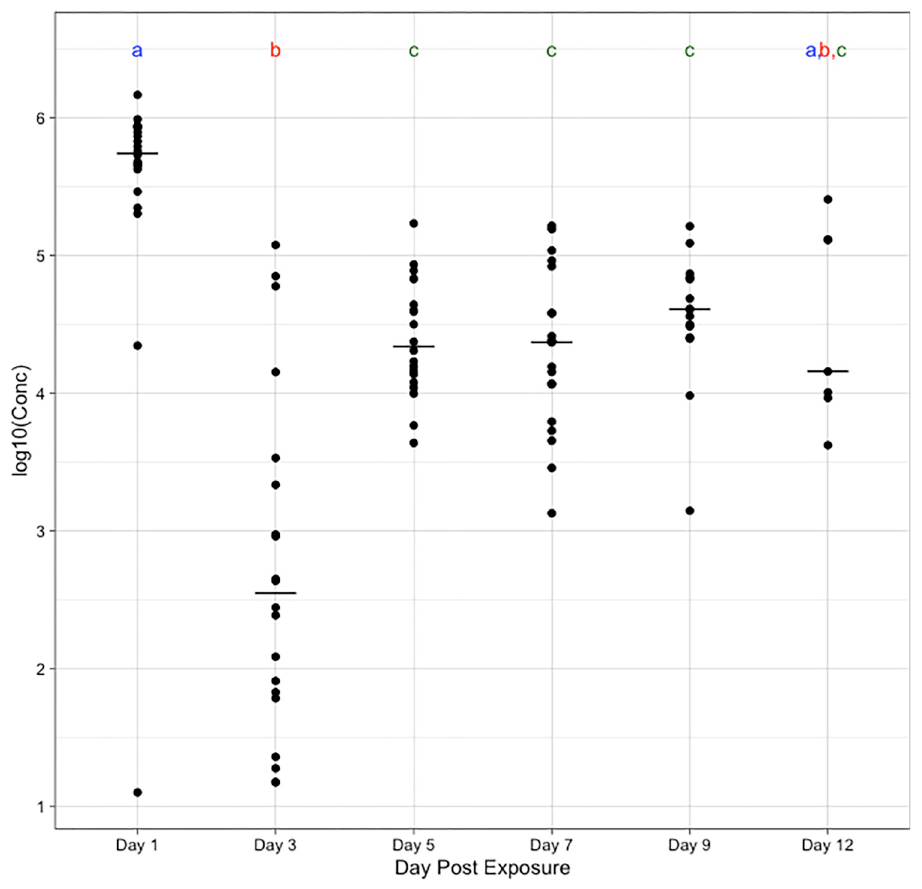
Fig 1. Concentration (log10) of rickettsiae in individual whole mosquitoes per time point after exposure to an R . felis -infected bloodmeal. Mosquitoes ingested R . felis and maintained infection over the course of 12 days. Lines represent the median and letters indicate significance grouping according to Dunn’s post-hoc